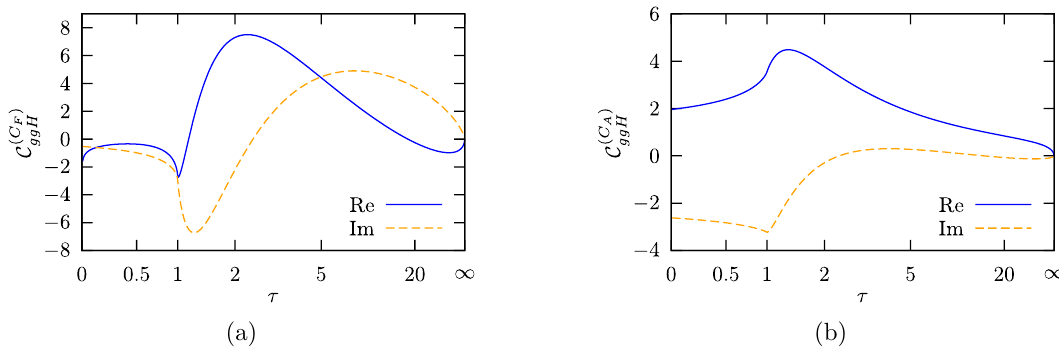
Figure 1. Contributions to ~ C (2) separated by their color factors. The quark mass is renormalized ggH in the on-shell scheme and the renormalization scale is set to (cid:22) 2 = M 2